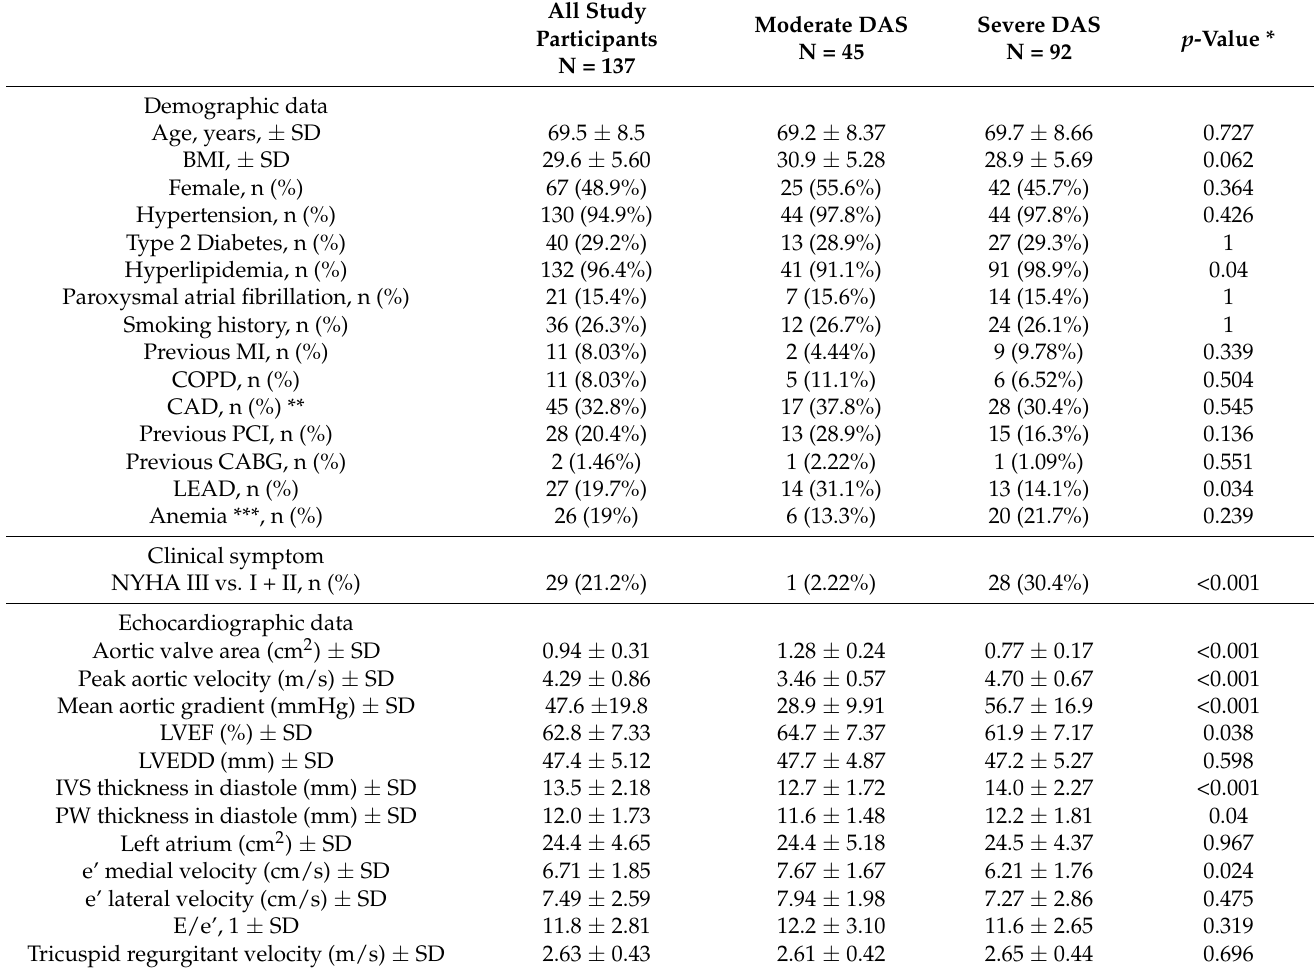
Table 1. Baseline study groups’